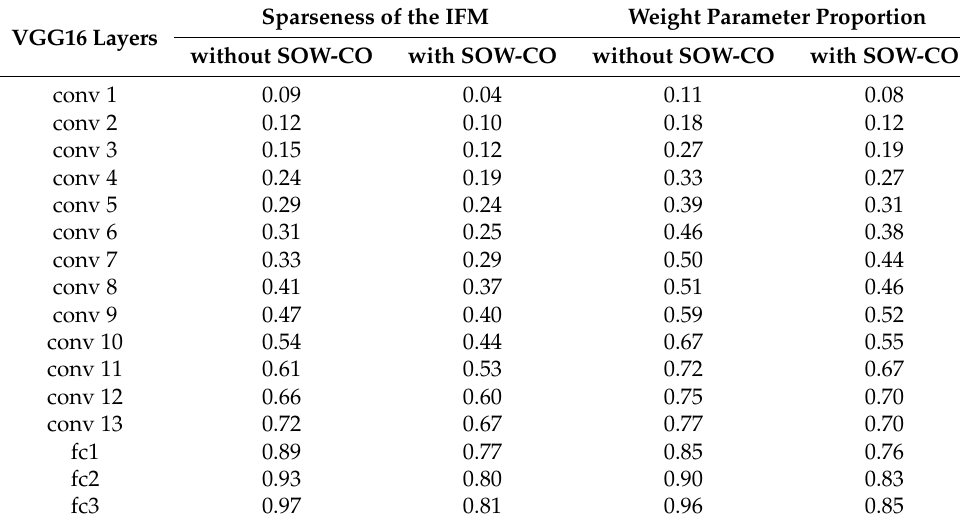
Table 6. Analysis of sparseness of the IFM and weight parameter proportion for VGG16. Sparseness of the VGG16 Layers